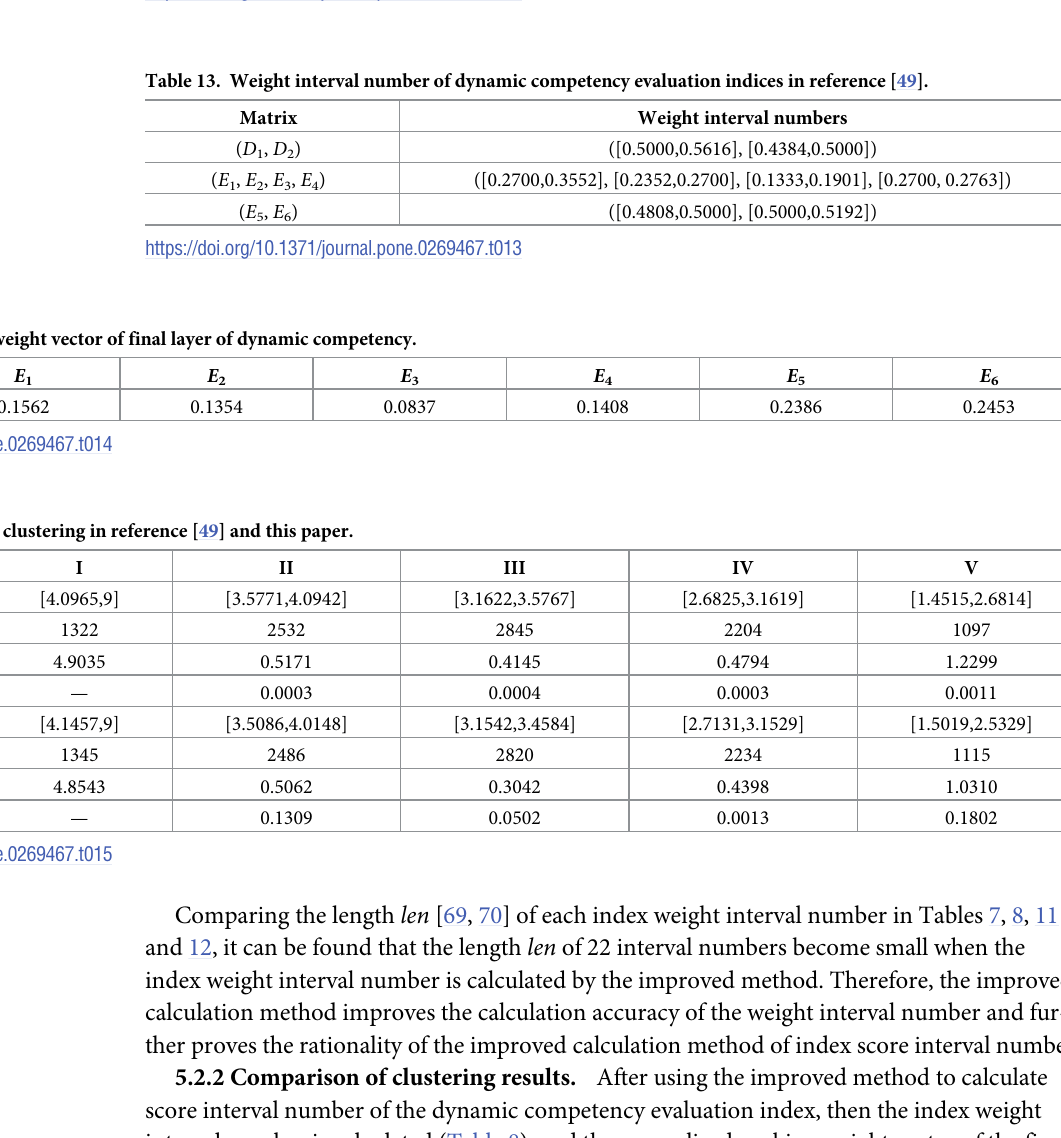
5.2.2 Comparison of clustering results. After using the improved method to calculate